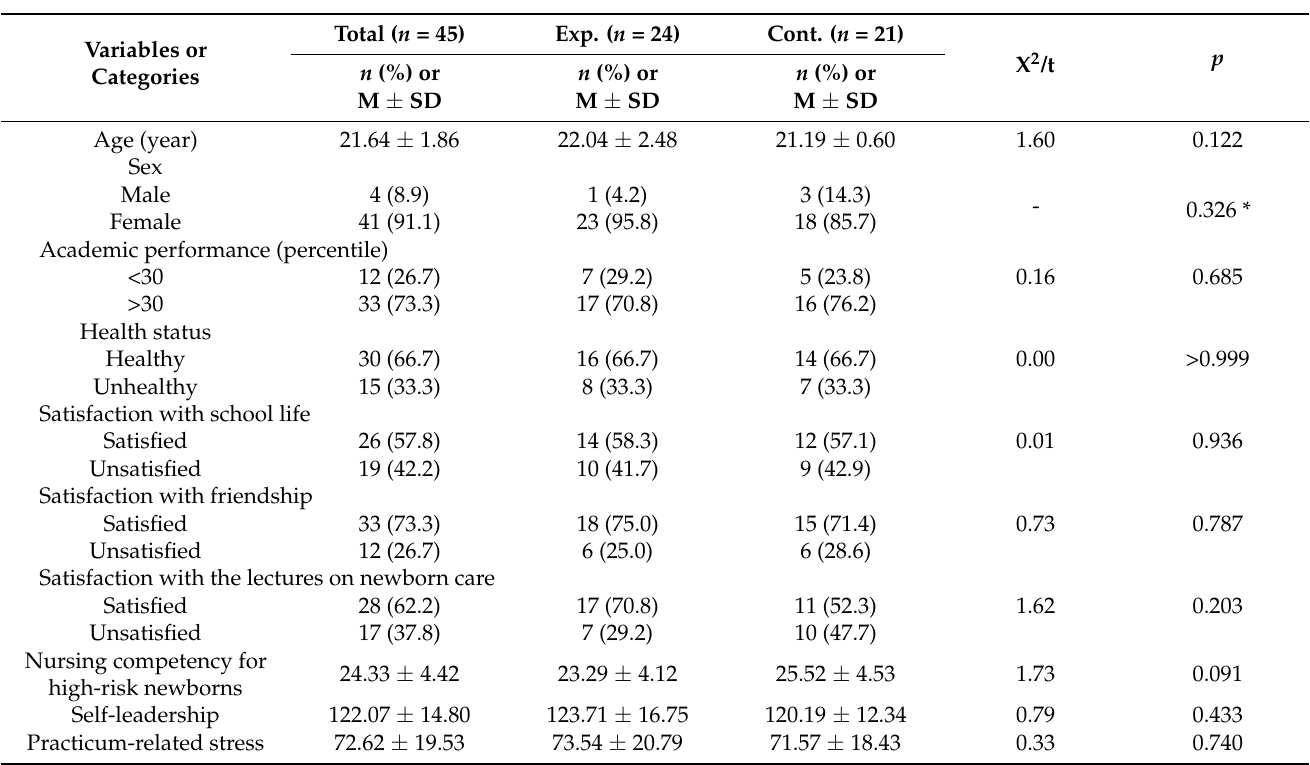
Table 2. Homogeneity testing of the general characteristics of the participants and outcome variables of the two groups ( n =